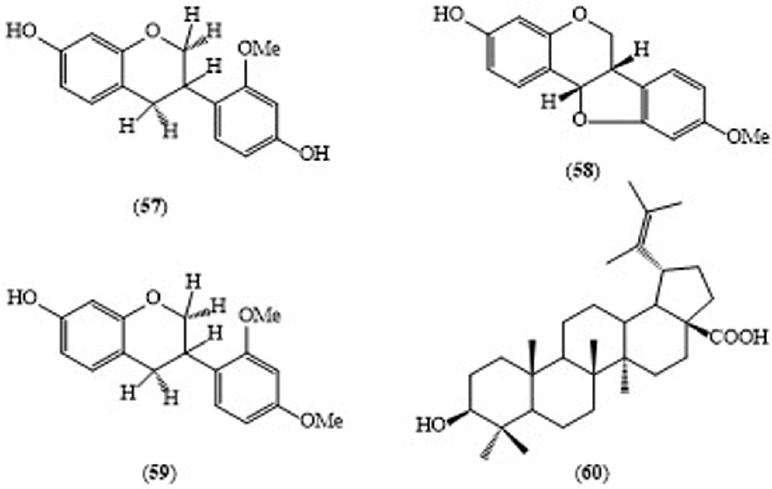
Figure 6. Structures of selected compounds isolated from Sesbania grandiflora.